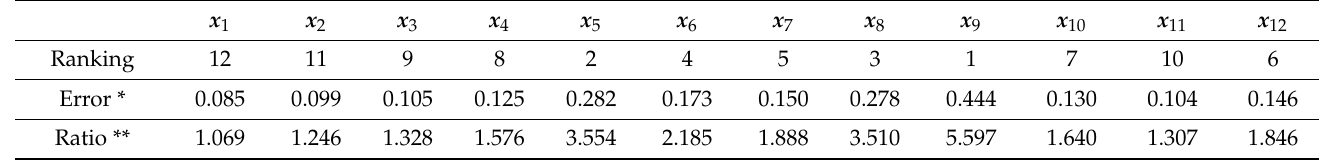
Table 4. Ranking of the importance of each evaluation